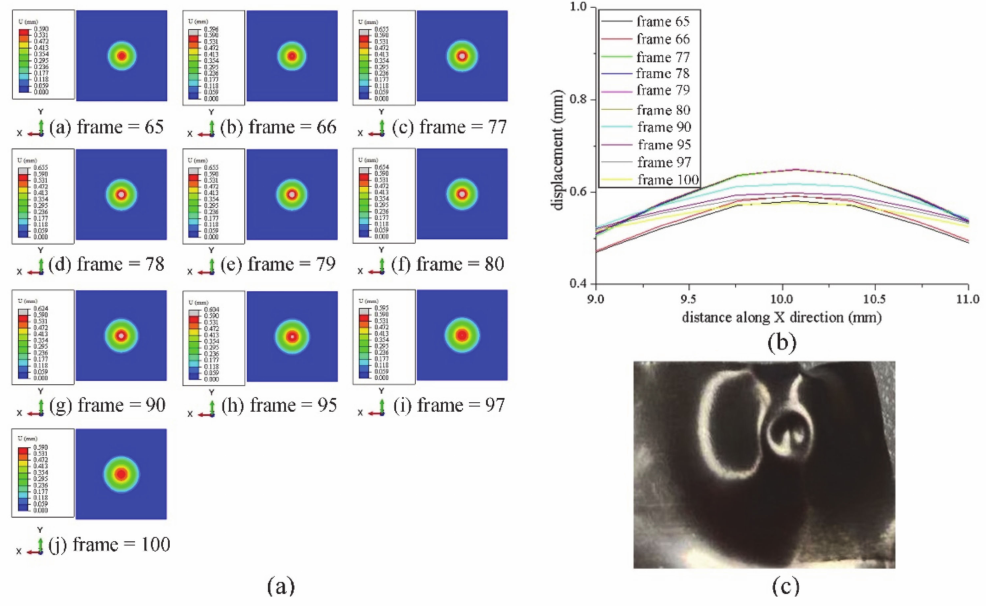
Figure 6. ( a ) Displacement cloud map of target under different frames. ( b ) Target displacement curve under different frames. ( c ) The experimental result of the